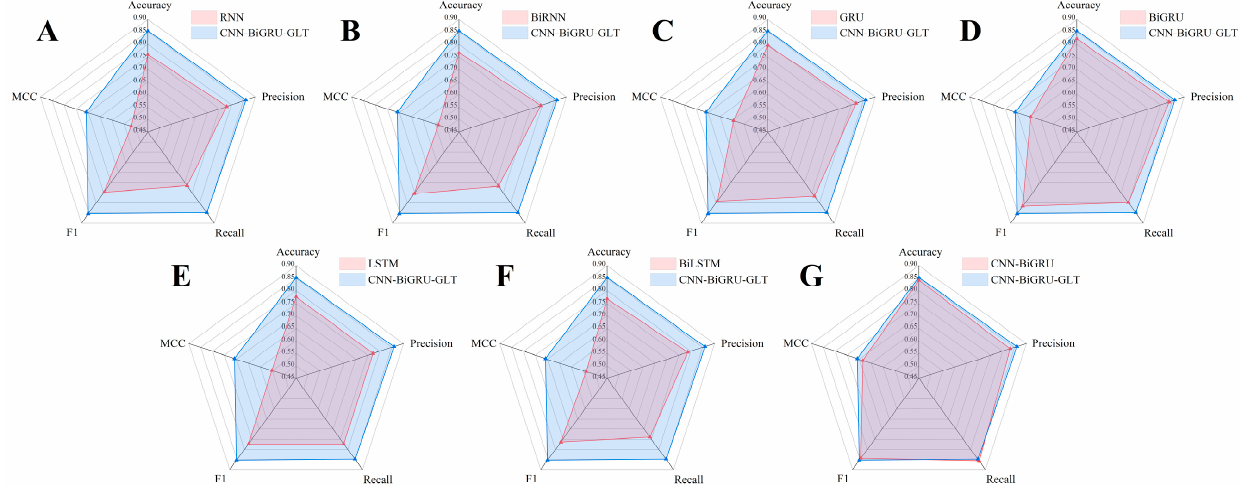
Table 3. Comparison of BiGRU and CNN-BiGRU performance on validation set.